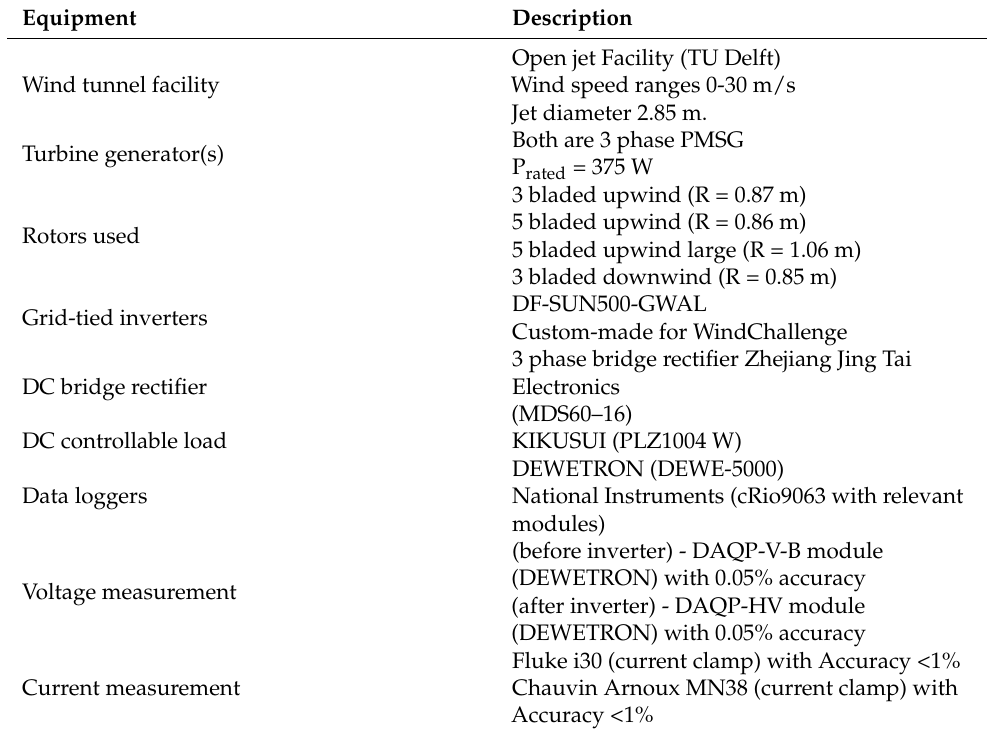
Table 1. Wind tunnel experimental equipment and relevant descriptions.